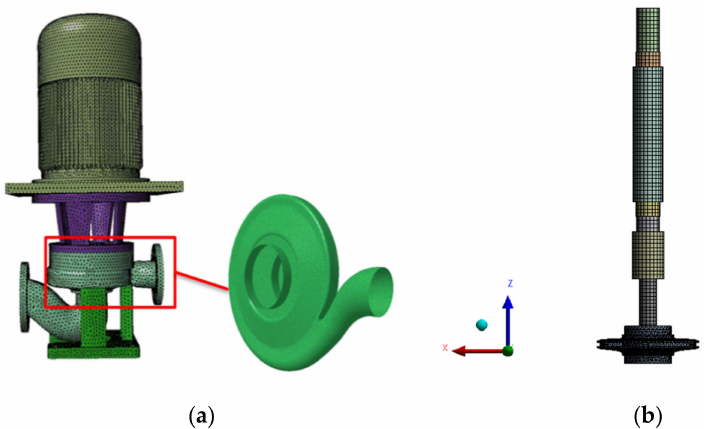
Figure 5. Finite element model of pump unit: ( a ) pump unit structure; ( b ) rotor